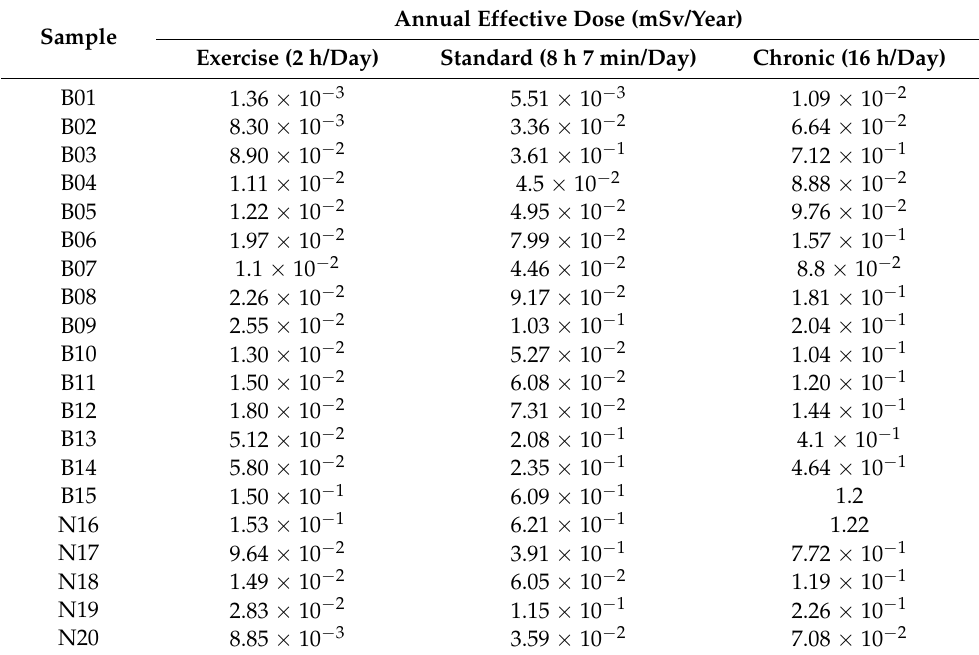
Table 2. Annual effective dose from present bracelets and necklaces for three different exposure times. Sample